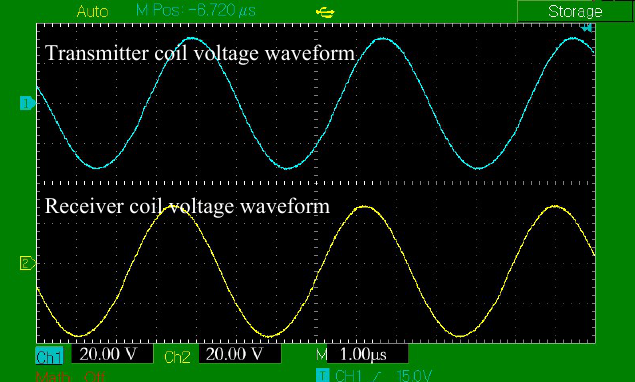
Figure 16. The experimental waveforms of case 2 under strongly coupled